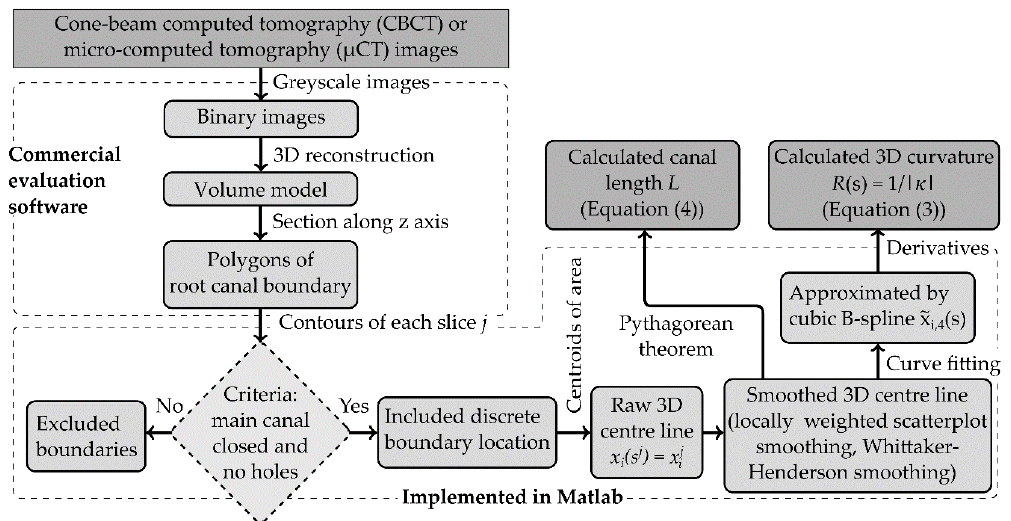
Figure 2. Exemplarily determination of centroids (reduced number slices per long axis of tooth): outer contour of first molar, 1 ; root canal morphology, 2 ; distal root canal (region of interest (ROI), red surface), 3 ; root canal’s cross-section slice (yellow lines), 4 ; centroid (blue points), 5 .